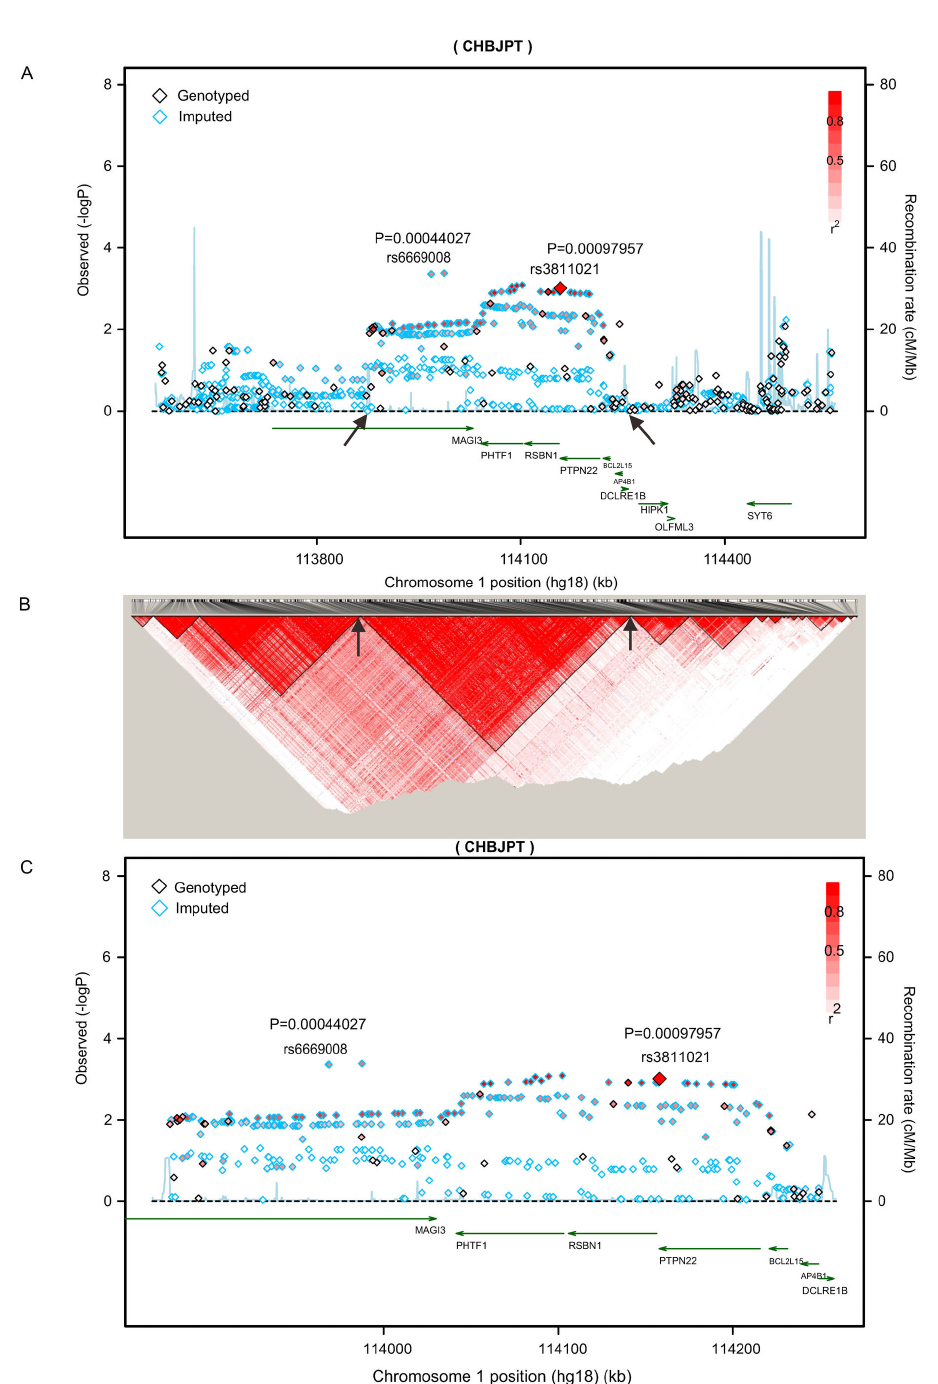
Figure 1. Regional plot of association results in LD block containing PTPN22 at 1p13.2 in GWAS stage. (A) The results of association for 1,277 genotyped and imputed SNPs in the 1.2-Mb region containing PTPN22 with Graves’ disease. The color of each SNP spot reflects its r 2 , with the top typed SNP (large red diamond) within each association locus changing from red to white. Genetic recombination rates, estimated using the 1000 Genomes pilot 1 CHB and JPT samples, are shown in cyan. Physical positions are based on NCBI build 36. (B) Linkage disequilibrium plots of the 1,277 SNPs in the 1.2-Mb region containing PTPN22 . The r 2 value is estimated by the genotype data of GD cases and controls enrolled in the GWAS. We constructed the plots using Haploview software version 4.2. (C) The plots of the association of 474 genotyped and imputed SNPs with GD. These 474 SNPs are located in a ~445-kb linkage disequilibrium region containing PTPN22 and were marked with arrows in panels A and B. doi: 10.1371/journal.pone.0084514.g001 PLOS ONE |